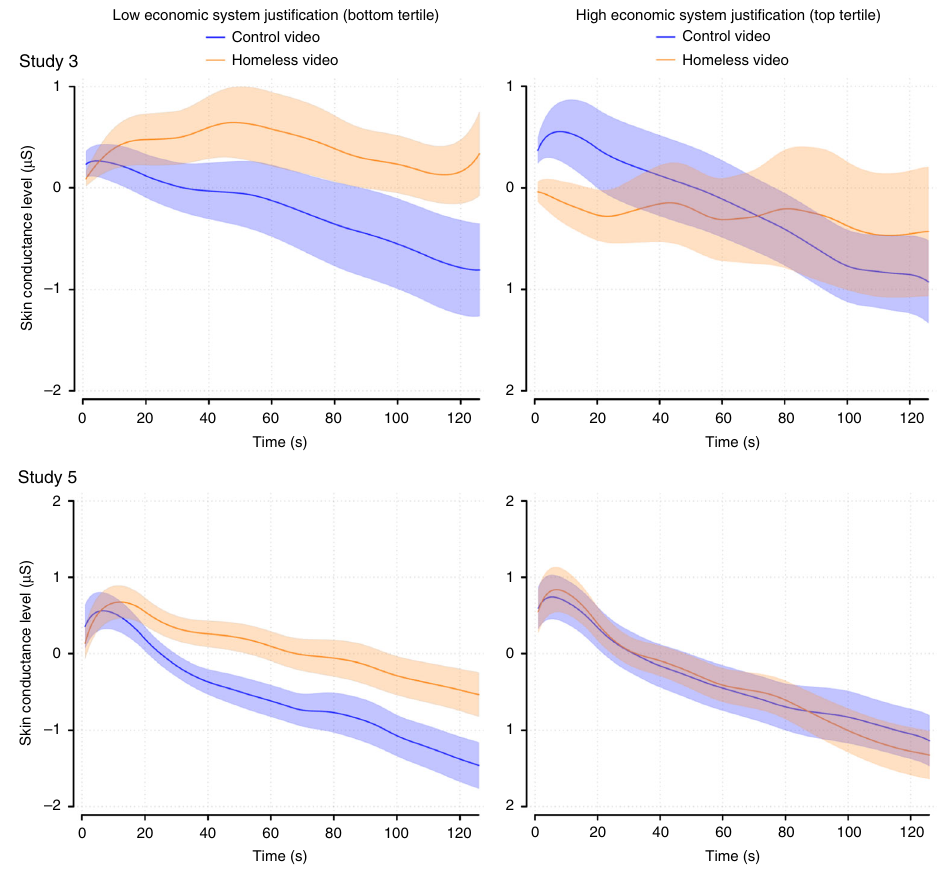
Fig. 2 Economic system justi fi cation predicts reduced skin conductance levels during depictions of people experiencing homelessness. The y-axis re fl ects activation relative to baseline. Colored bands indicate ±1 SE. LOWESS smoothing applied.